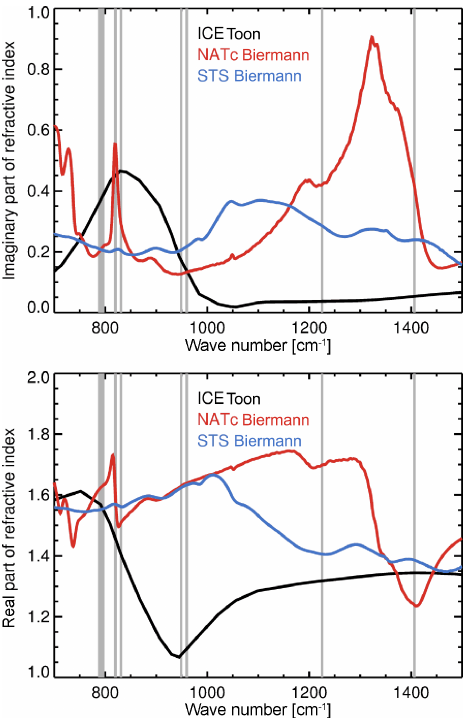
Figure 2. Refractive indices (imaginary part at top and real part at lower panel) of ice clouds (Toon et al., 1994), coated NAT (Bier- mann et al., 2000; Höpfner et al., 2006a), and STS with weight per- centages of composition of 17wgt% HNO 3 and 25wgt% H 2 SO 4 (Biermann et al., 2000). The wavelength regions applied in the clas- sification scheme are superimposed in